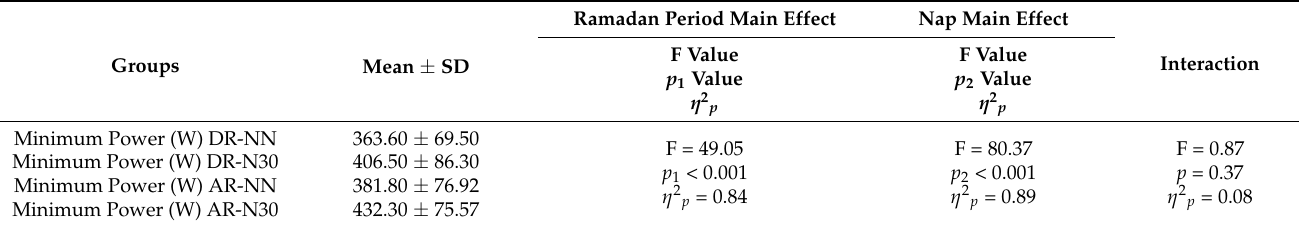
Table 2. Comparison of the measured values of the Minimum Power (W) (n = 10).